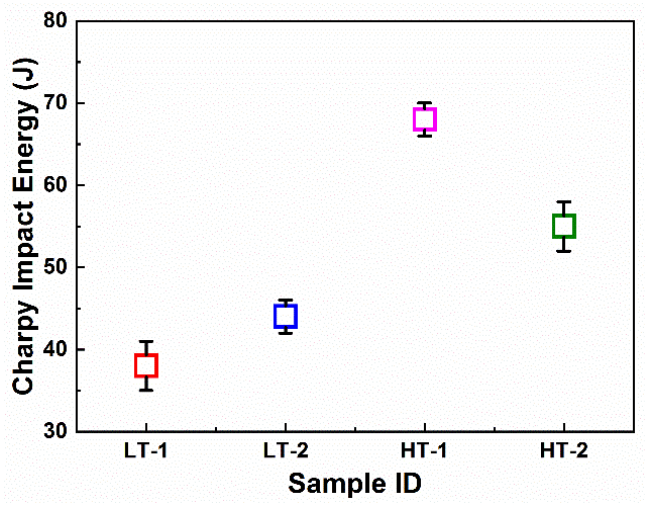
Figure 8. Charpy impact properties of ballistic steel samples.